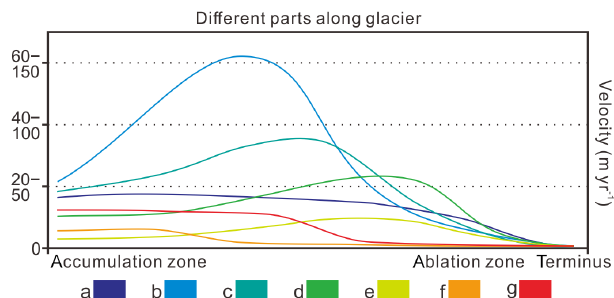
Figure 10. Conceptual characterization of the glacial motion pattern of surge-type glaciers in the Kingata Mountains. Profile a to Profile g indicate different stages during the active and quiescent phases of a surge-type